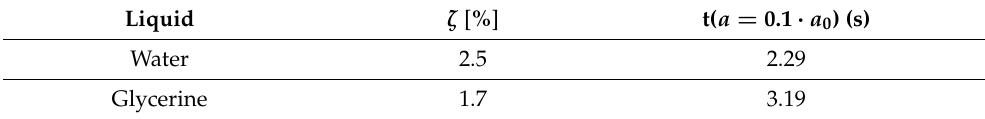
Table 2. Damping ratio and characteristic decaying time for the water and glycerine cases.